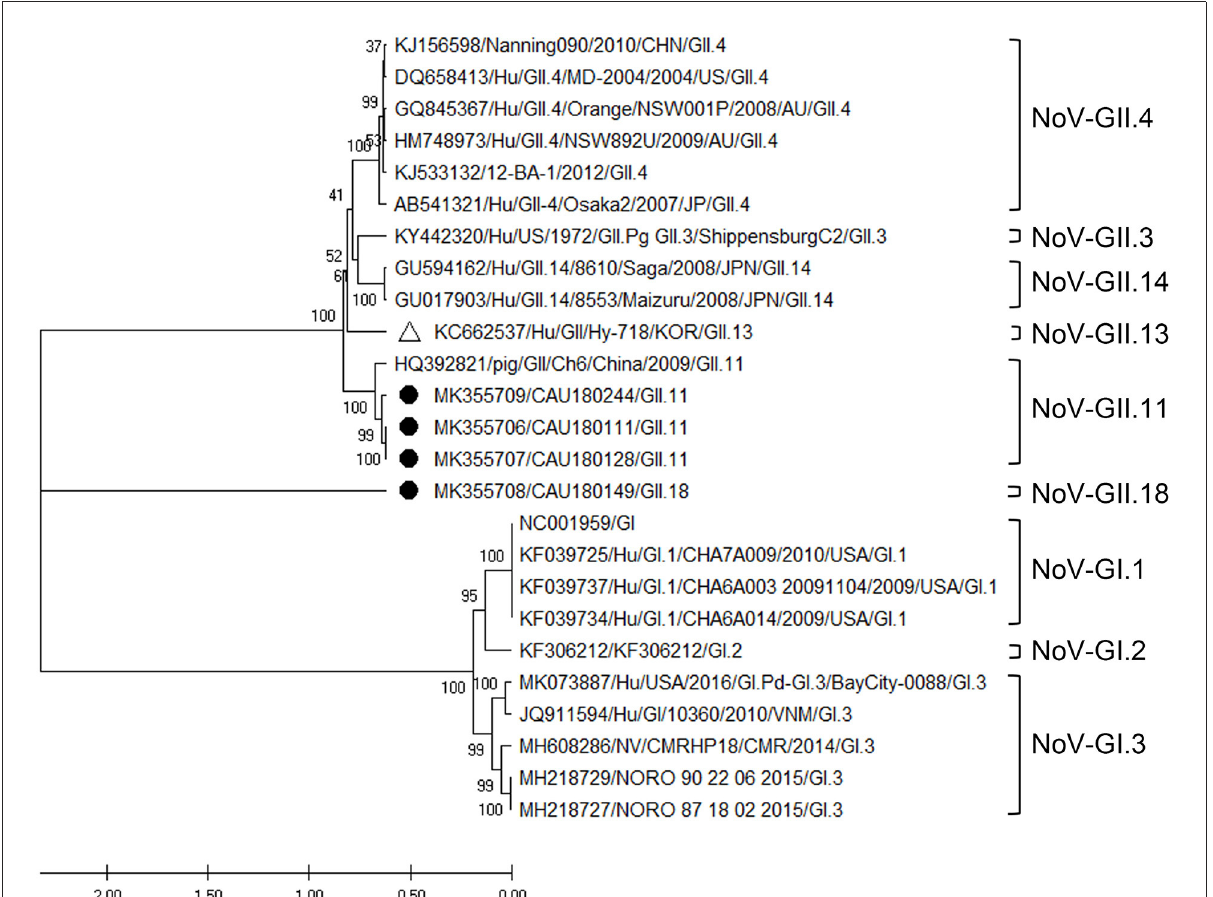
FIGURE6 Phylogenetic analysis of NoV detected in porcine stools and swabs. The NoV phylogenetic tree was constructed following the UPGMA method and based on 310-bp sequences of the RdRp region. Sequences detected in this study are labeled with black circles (•). The white triangle ( 1 ) represents the human NoV strain (KC662537/Hu/GII/Hy-718) that was confirmed in the Republic of Korea. As reference sequences, NoV-GII.4 (six strains), GII.3 (one strain), GII.14 (two strains), GII.13 (one strain), GII.11 (one strain), and GI (10 strains) were used. The numbers at the nodes of the tree indicate bootstrap values and the scale bar indicates nucleotide substitutions per